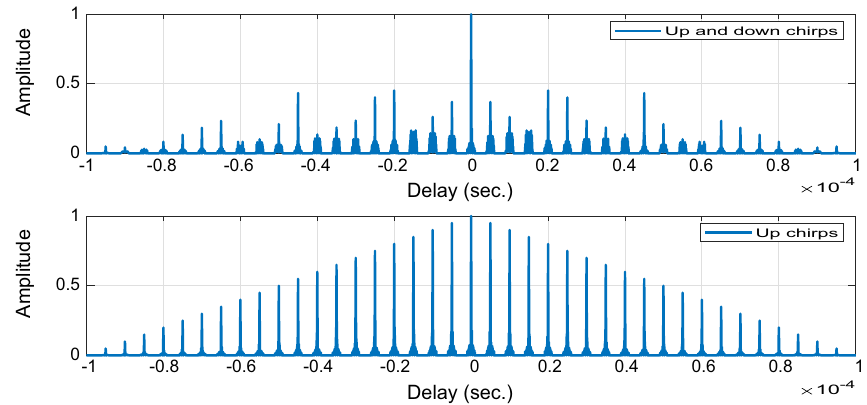
Fig. 6 Zero-Doppler cut of the CAF for a sequence of a-(top)) up- and down- chirps, b-(bottom)) only